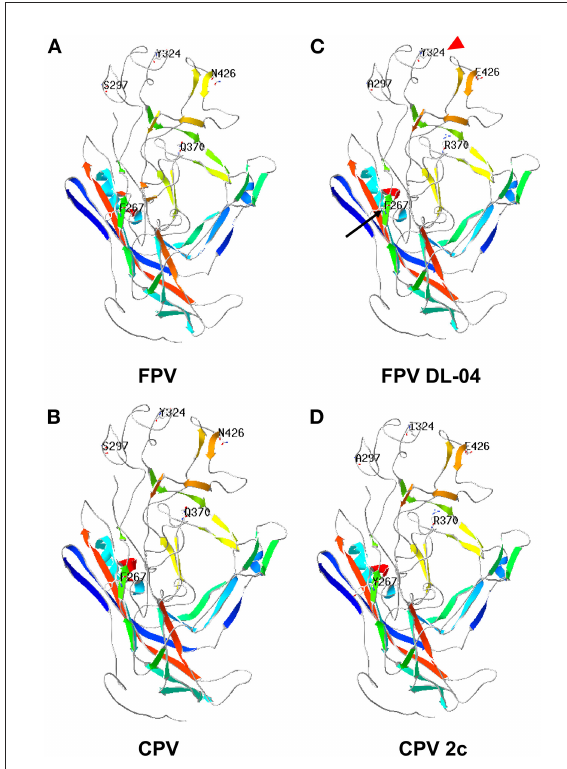
FIGURE3 Prediction of VP2 protein structure of the FPV DL04 strain. The protein structure of the VP2 protein of the FPV DL04 strain was predicted online using the Swiss Model software (https:// swissmodel.expasy.org). The CPV VP2 structure (PDB ID: 4dpv.1) was used as the template. The predicted VP2 protein structure was analyzed using the Swiss-PDB Viewer software, and the mutation sites were displayed. (A) FPV, (B) CPV, (C) FPV DL-04, (D) CPV 2c.